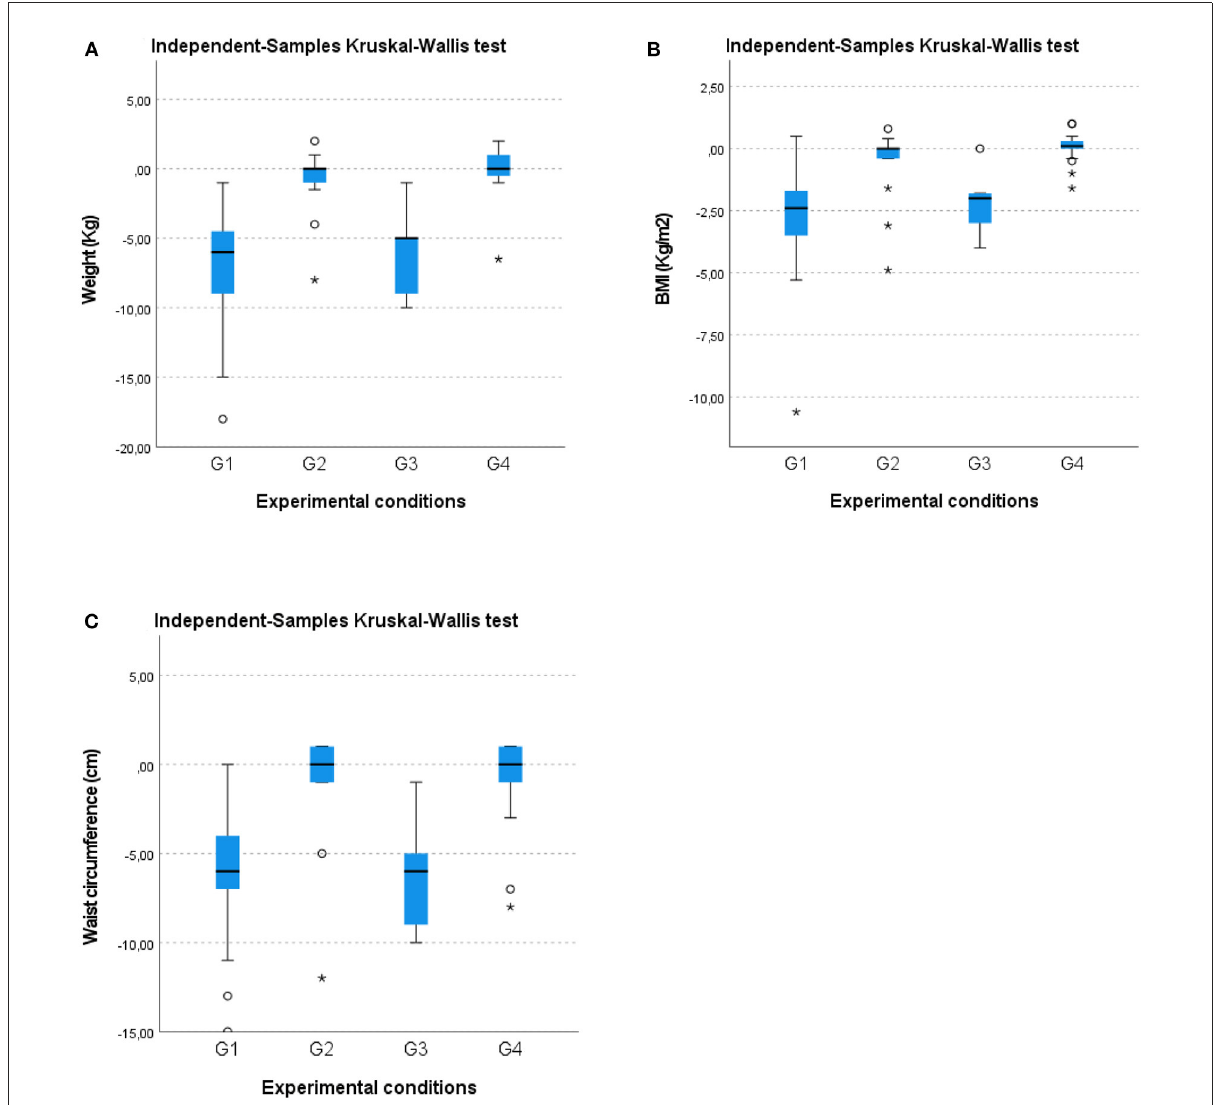
FIGURE2 Box-whisker plots showing (A) weight (kg), (B) BMI (kg/m 2 ), and (C) waist circumference (cm) changes in the four groups at the 12-month follow-up (T1). O, Outliers; *,